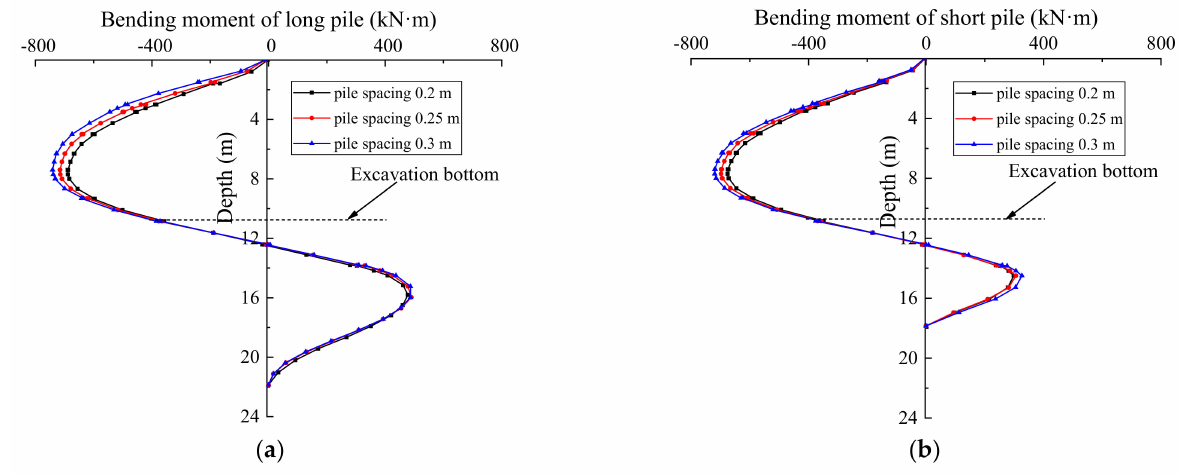
Figure 18. Bending moment of the pile at different spacing: ( a ) long pile; ( b ) short